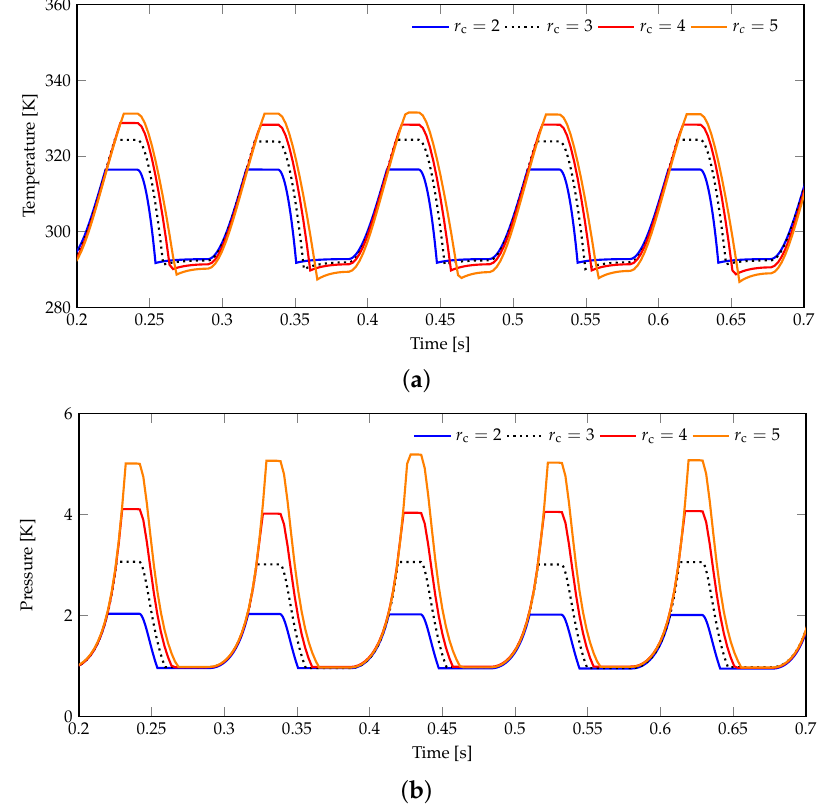
Figure 12. The simulation results for cyclic behaviour of the compressor in a) gas temperature and b) gas pressure, inside the compressor chamber.